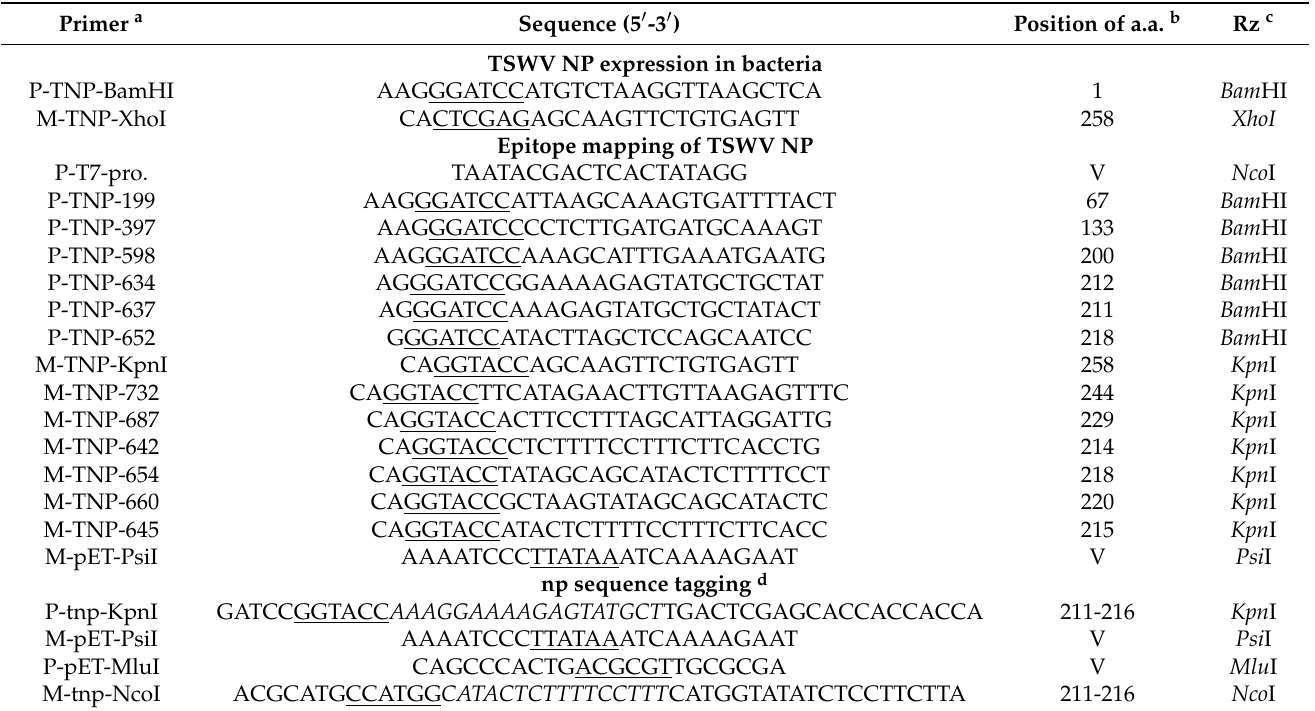
a The P indicates forward primer and M indicates reverse primers. b The numbers indicate the positions of the amino acid (aa) in the nucleocapsid protein (NP) of tomato spotted wilt virus (TSWV). The V indicates primers complementary to vector sequences. c Rz indicates the restriction enzyme sites for cloning. d The np-tag sequence is indicated in